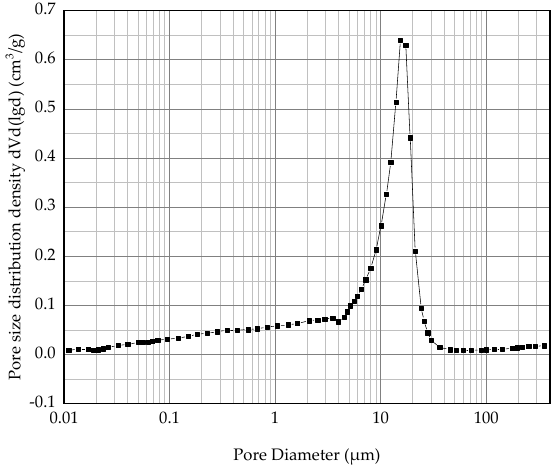
Figure 17. Pore size distribution density curve of soil sample 2.